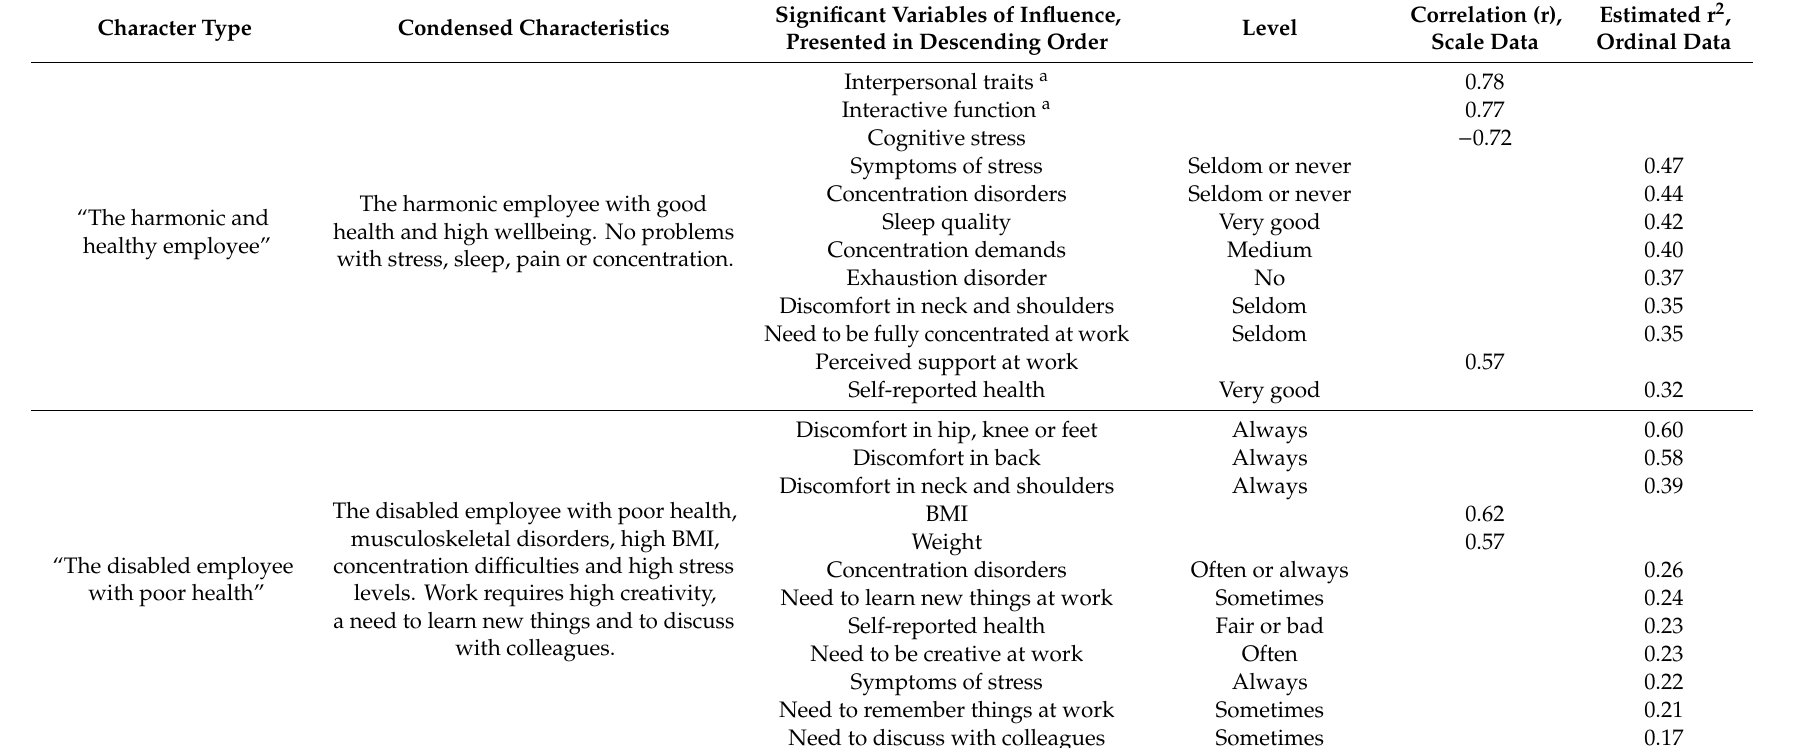
Table 2. Presentation of the character types, based on variables of influence from the factor analysis of mixed data. Covariates and factors for each character type are presented in descending order, based on